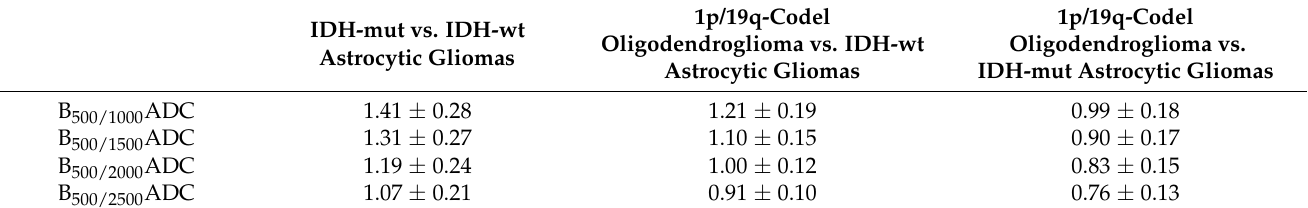
Table 3. B 500 -average ADC values of the three glioma subgroups (10 − 3 × mm 2 /s).